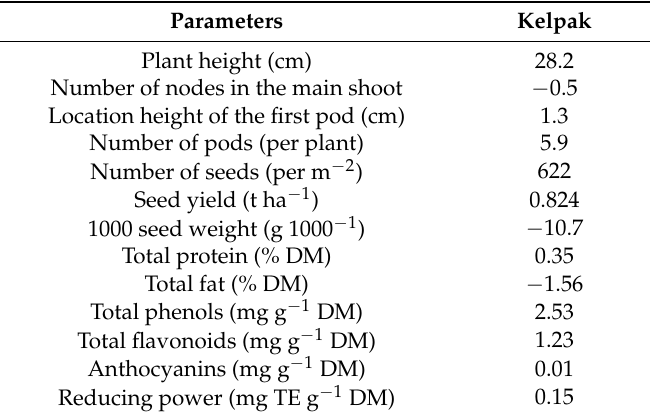
Table 4. The index of biostimulant effect